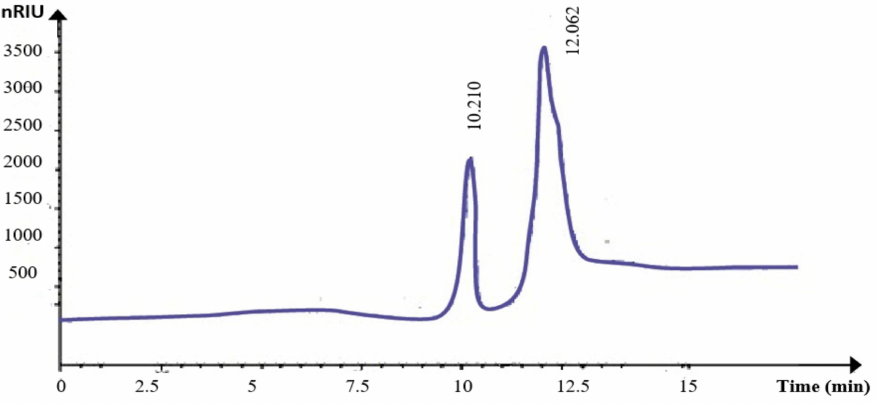
Figure 5. HPLC analysis of